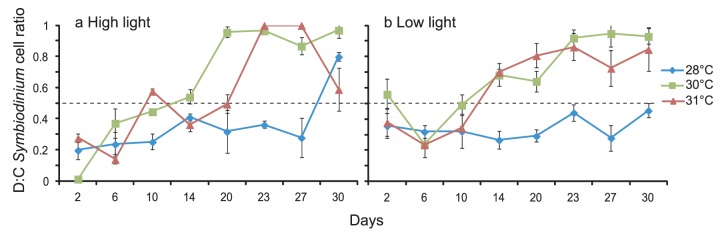
Change in Symbiodinium D∶C cell ratios (±1 SE) over time in Acropora millepora juveniles at 28, 30, or 31°C in: (a) high light (390 µmol photons m−2 s−1), or (b) low light levels (180 µmol photons m−2 s−1).Dotted line represents equal proportions of Symbiodinium types D and C cells within the juveniles. Ratios closer to 1 are dominated by type D; ratios closer to 0 are dominated by type C. N = 10 per data point.